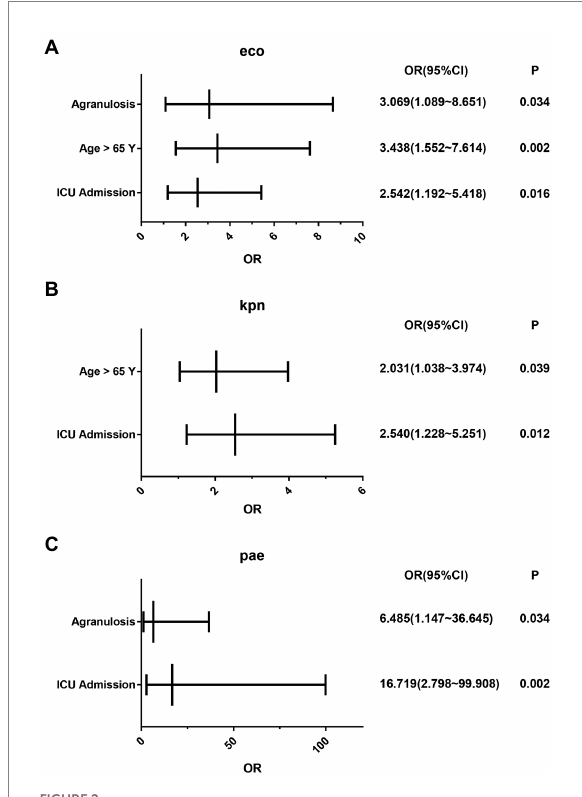
FIGURE 2 Analysis of independent risk factors for death in patients with Gram-negative bacteria bloodstream infection. (A) Independent risk factors for death in patients with bloodstream infection with E. coli . (B) Independent risk factors for death in patients with bloodstream infection with K. pneumoniae . (C) Independent risk factors for death in patients with bloodstream infection with P. aeruginosa